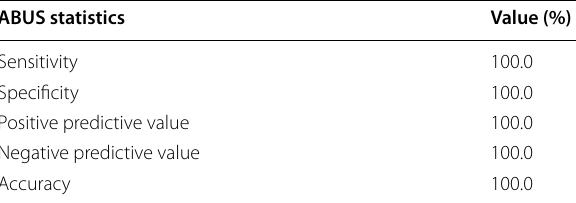
Table 8 ABUS accuracy measures